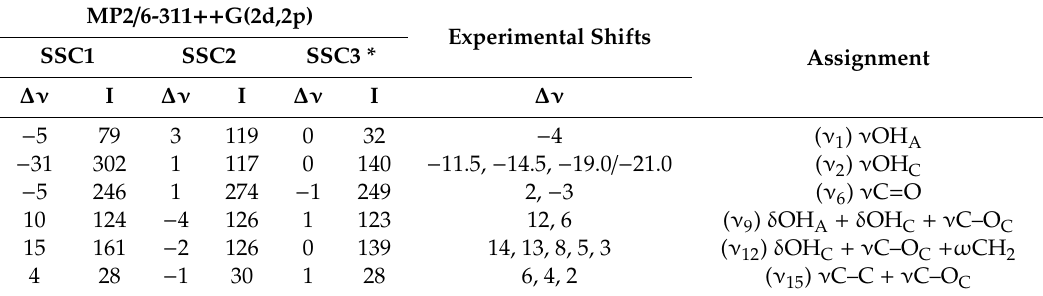
Table 4 contains the most characteristic wavenumber shifts ( ∆ ν = ν complex − ν monomer ) calculated for the 1:1 species of interest compared to the experimental values. From now on the notation OH C and OH A denotes carboxylic and alcoholic OH group, respectively. Table 4. MP2 / 6-311 ++ G(2d,2p) calculated wavenumber shifts ∆ ν (cm − 1 ) and intensities (km mol − 1 ) of the SSC complexes a with nitrogen compared to the corresponding experimental shifts. MP2 / 6-311 ++